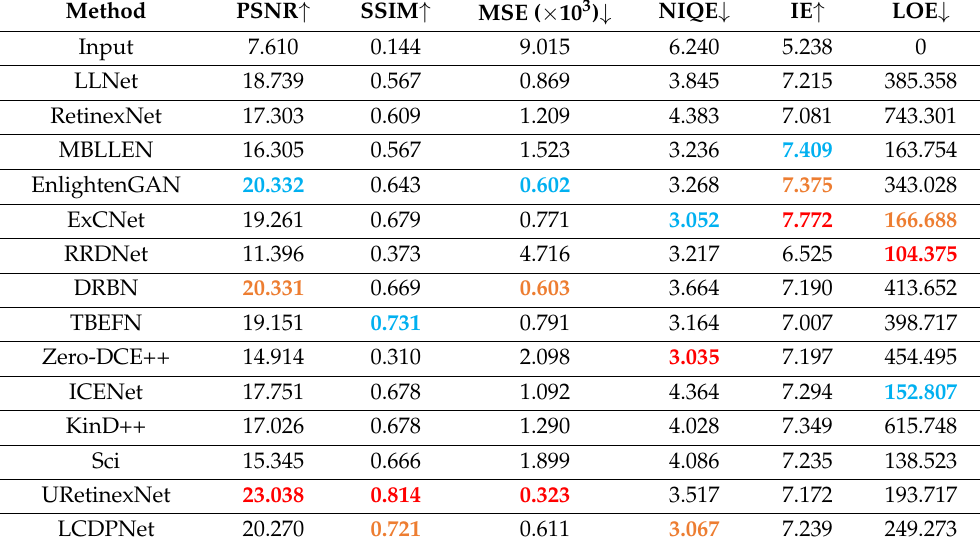
Table 6. Quantitative comparison of the LOL datasets (Paired Dataset) according to PSNR, SSIM, MSE, NIQE, IE, and LOE. The best result is bold in red , the second result is bold in blue , and the third result is bold in yellow .